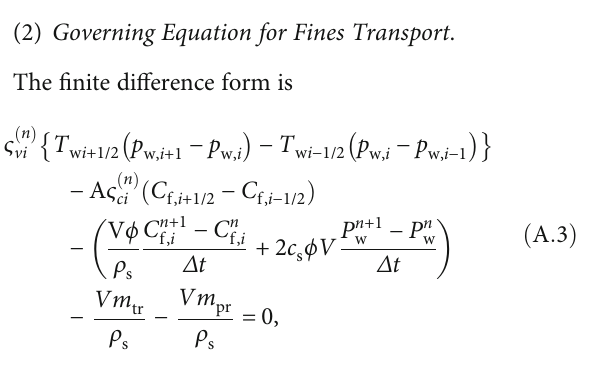
Figure 12: The history results with and without considering fi nes